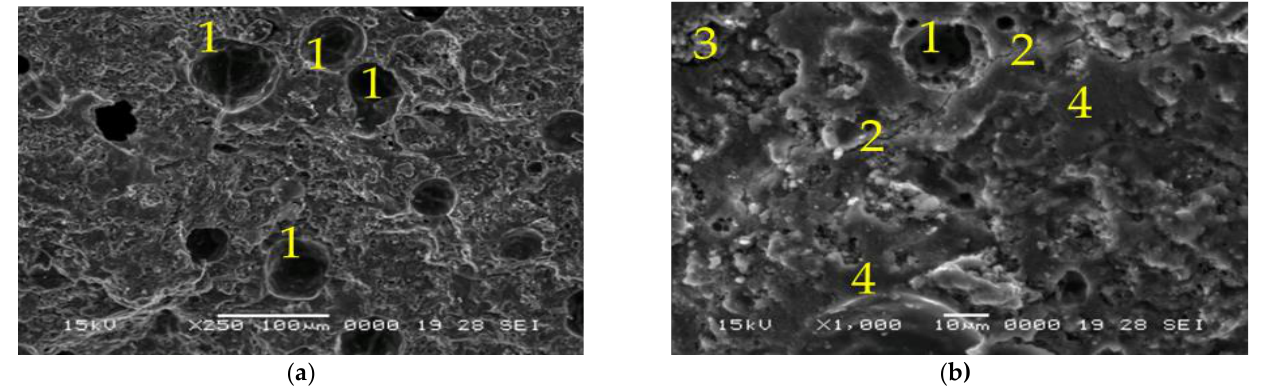
Figure 7. SEM micrographs of: ( a , b ) Sample 6MX1, ×250, respectively, ×1000 magnification (1 — pores, 2 — microcracks, 3 — partially reacted fly ash and 4 — dense zone of reacted fly ash) .